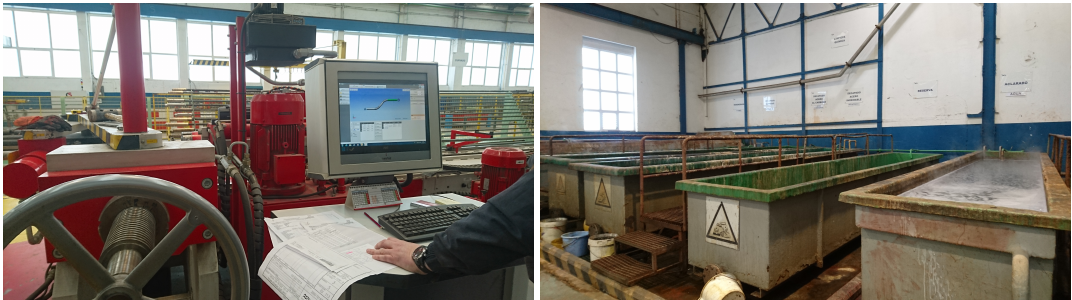
Figure 4. Computerized bending machine ( left ) and cleaning tubs of the pipe workshop ( right